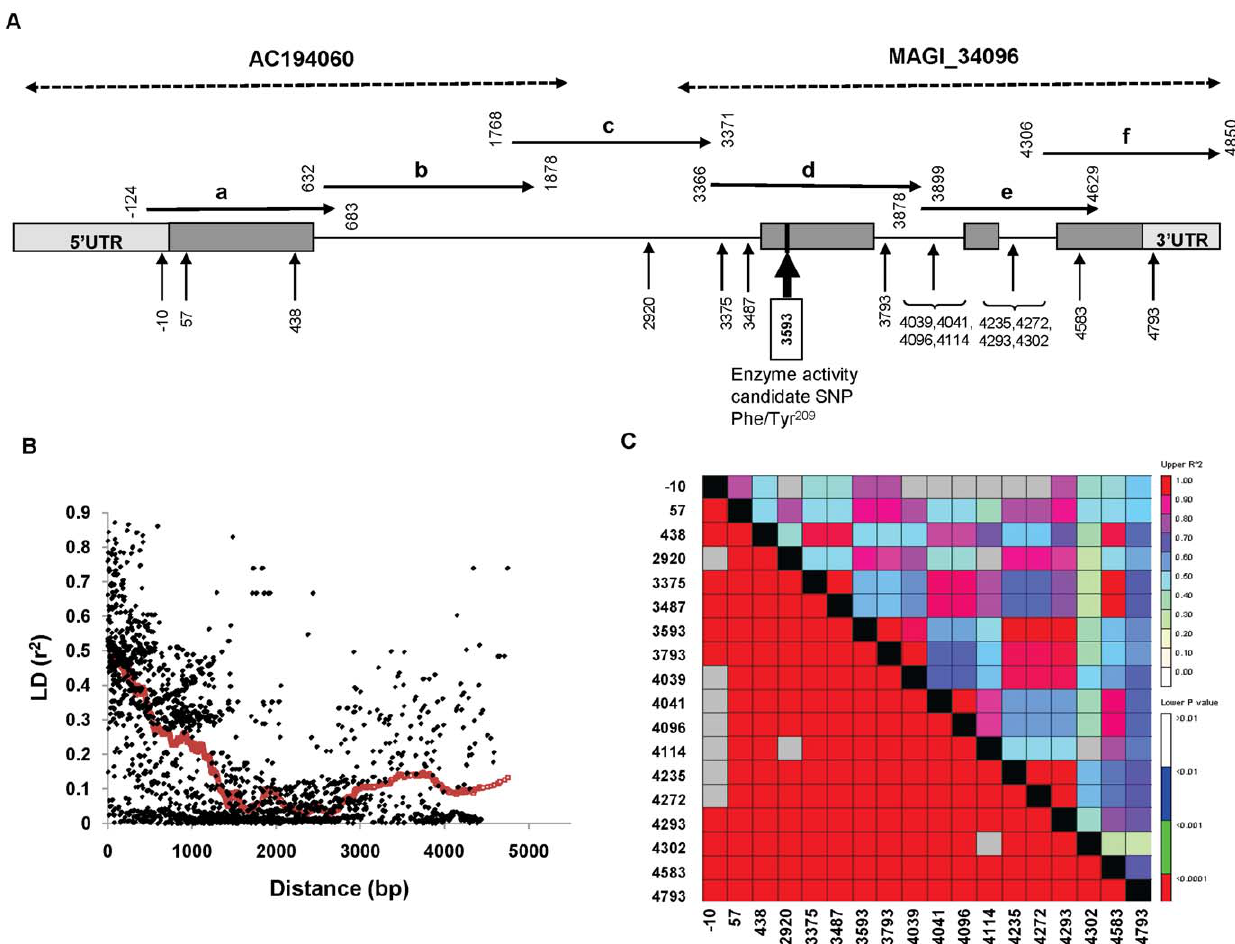
Figure 1. Gene model, LD structure and sequencing coverage of the idh gene. ( A ) idh gene model. Dark gray boxes represent exons. Light gray boxes are the 5 9 and 3 9 UTRs. Vertical arrows and numbering below the gene model are the locations of SNPs that showed significant association with IDH activity. Dashed arrows above the gene are the BAC and MAGI contigs that were used as reference sequence for primer design. Horizontal arrows above the gene represent the sequenced amplicons that were used for genotyping. Regions a, c, d, and f were sequenced across 288 maize lines, region e was sequenced across 100 lines, and region b was first sequenced across four lines and then genotyped across the 288 inbred line set. ( B ) LD plot for squared correlations of allele frequencies ( r 2 ) against distance between polymorphic sites within the idh gene in 100 lines. R ed dots represent average r 2 . ( C ) LD plot for the sites of idh significantly associated with IDH activity.